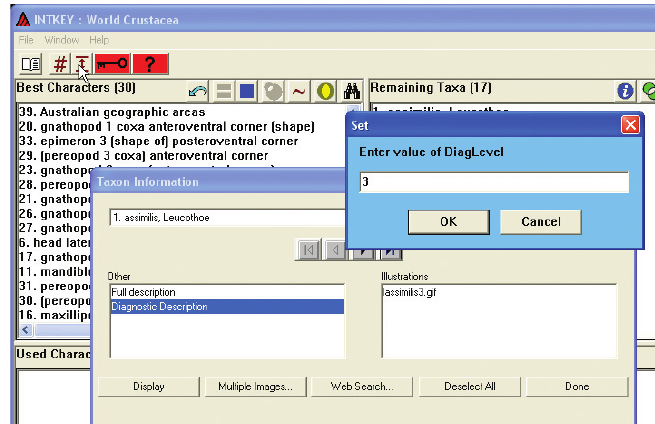
Figure 56. Raising the diagnostic